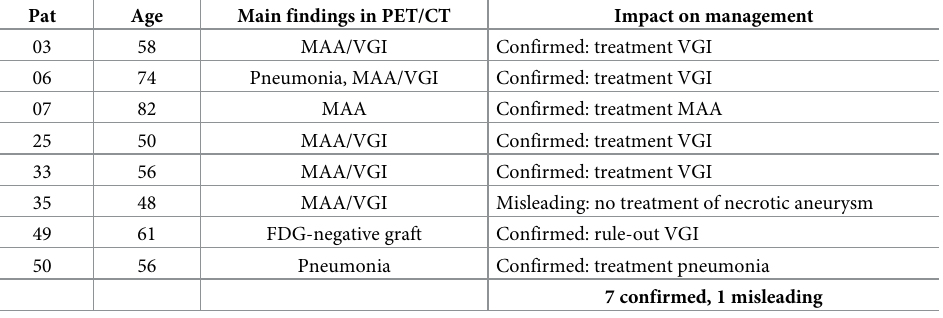
Table 4. Impact on patient management of baseline PET/CT scans with the referral question: Vascular graft infec- tion (n = 8). Pat